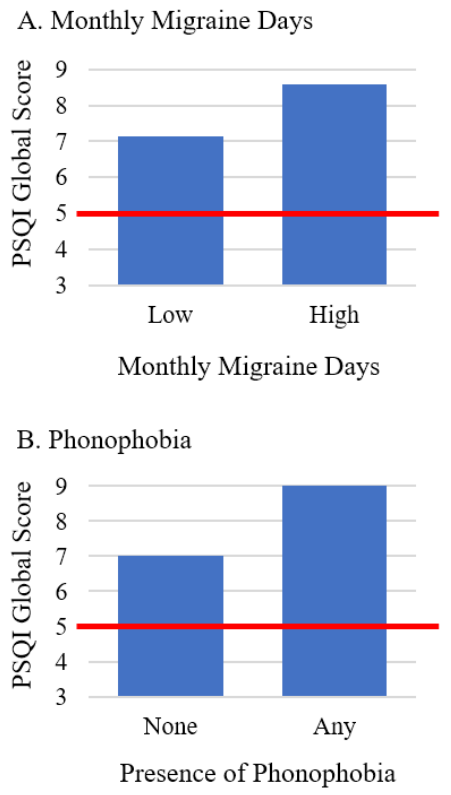
Figure 2. Differences in overall sleep quality by monthly migraine days ( A ) and presence of phonophobia ( B ), after controlling for body mass index and potential confounders. Note. The